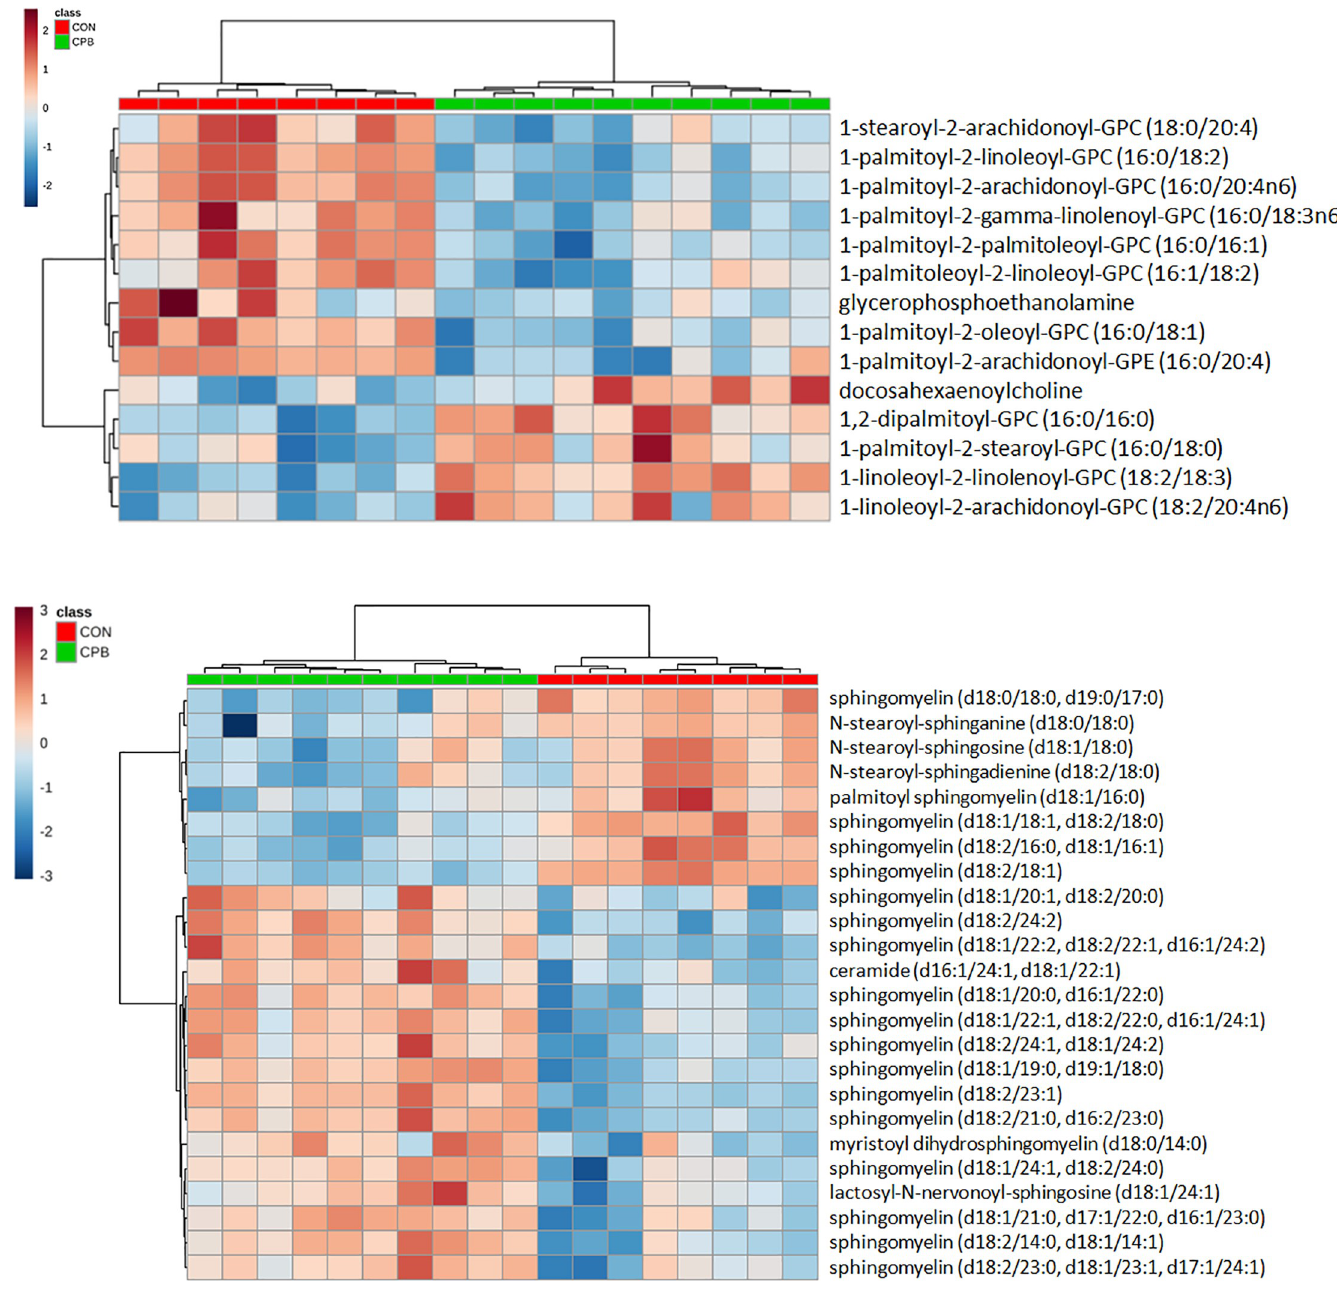
Fig 3. Heatmaps of changes of phospholipids (A) and sphingomyelins (B) from baseline to 6 months. Legends: diet groups are represented by red (CON) and green (CPB) boxes on the top of the heatmaps; Keys: orange indicates increases while blue indicates decreases from baseline.